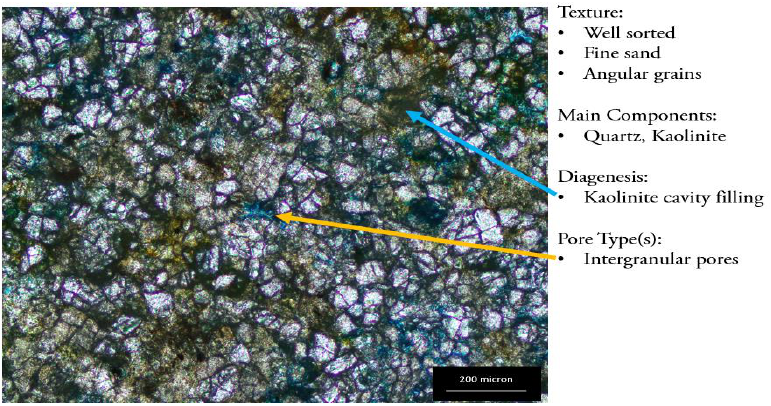
Figure 11. Textural and compositional features of L302 Temburong.